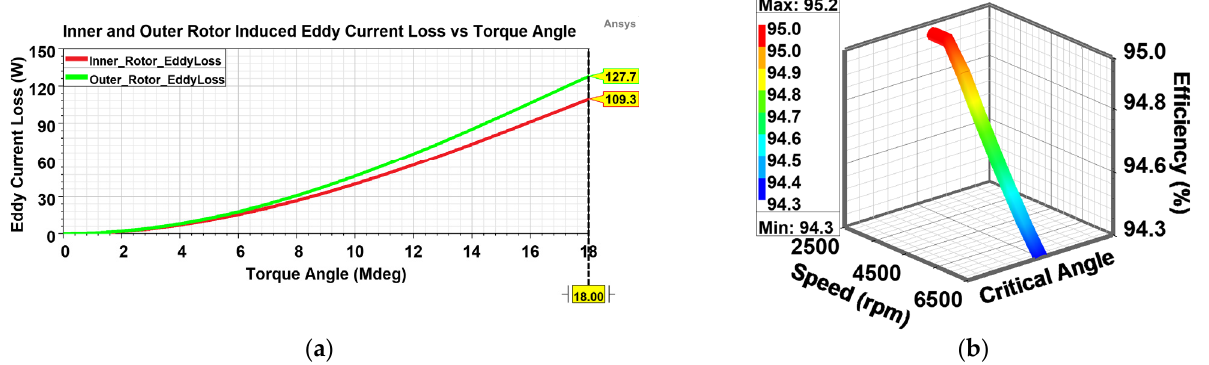
Figure 20 . ( a ) Induced eddy-current losses on PMs; ( b ) Efficiency of the MC at maximum speed.